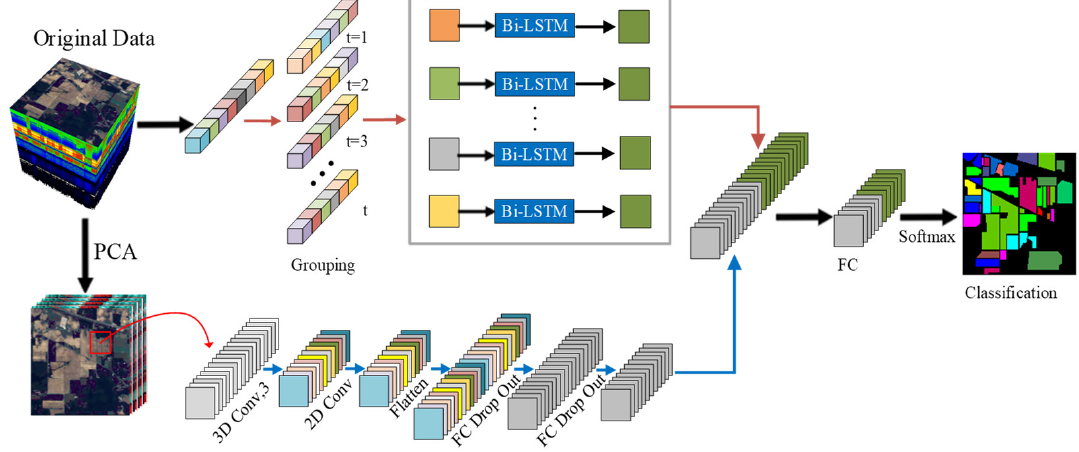
Figure 4. Framework diagram of the Bi-LSTM-CNN.